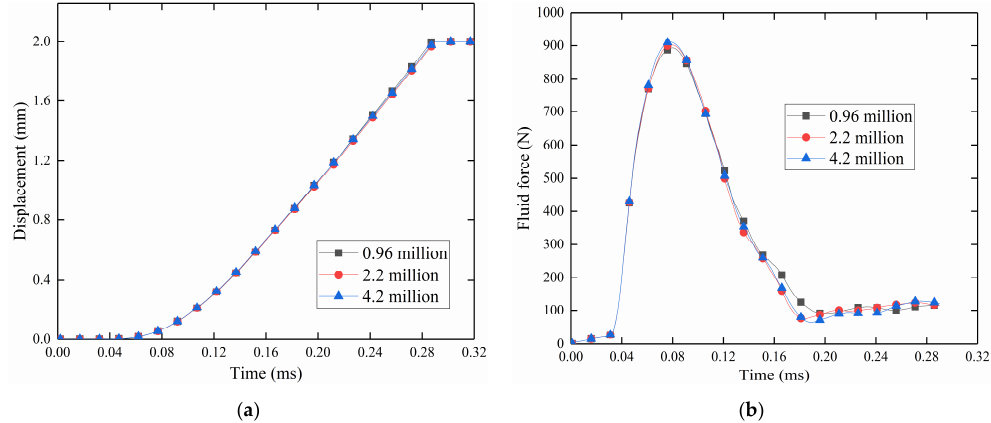
Figure 8. Mesh independence test: ( a ) Displacement of the valve spool in the three models; ( b ) Fluid force characteristic of the three